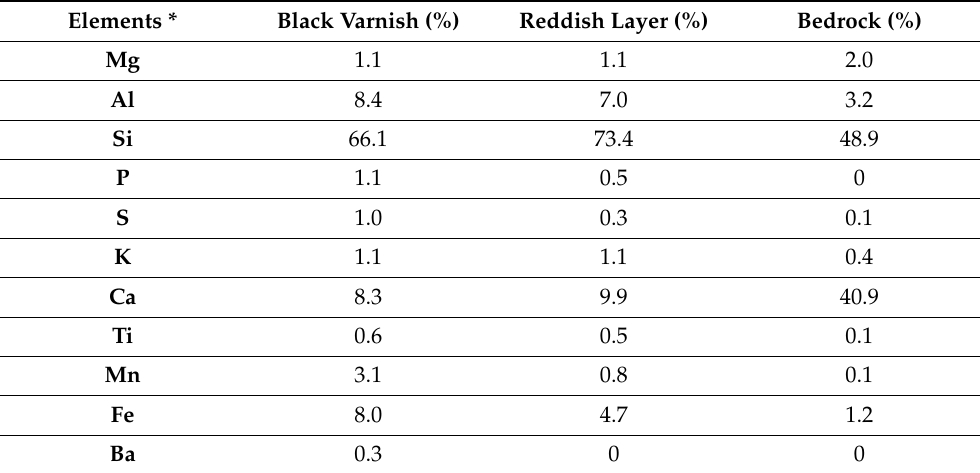
Table 2. XRF data (%) of the three layers of sample AV1. Elements * Black Varnish (%) Reddish Layer (%) Bedrock (%)